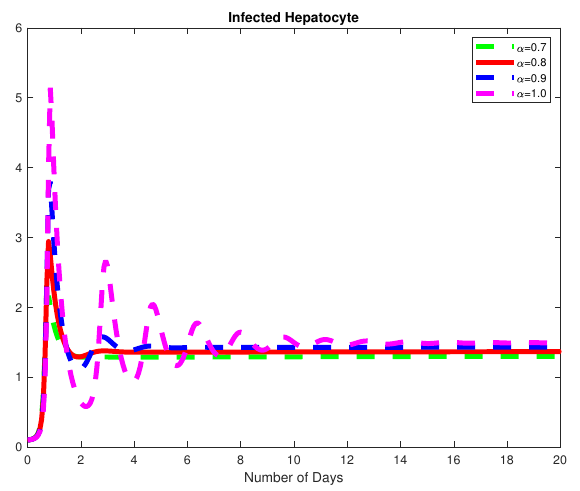
Figure 1. The dynamics of the healthy hepatocytes, H , for varying fractional order α .